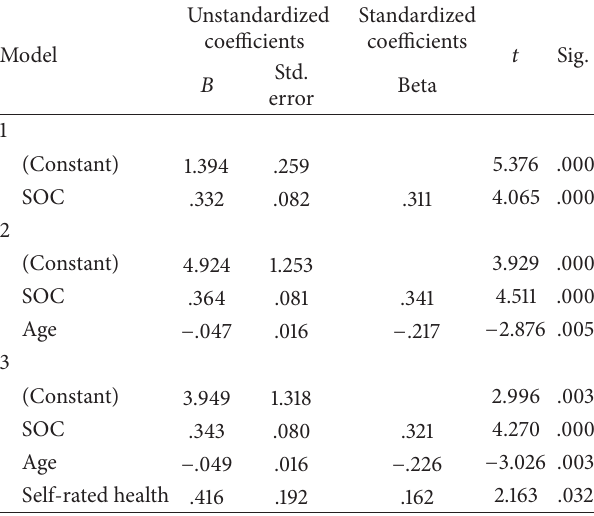
Table 3: Predictors of